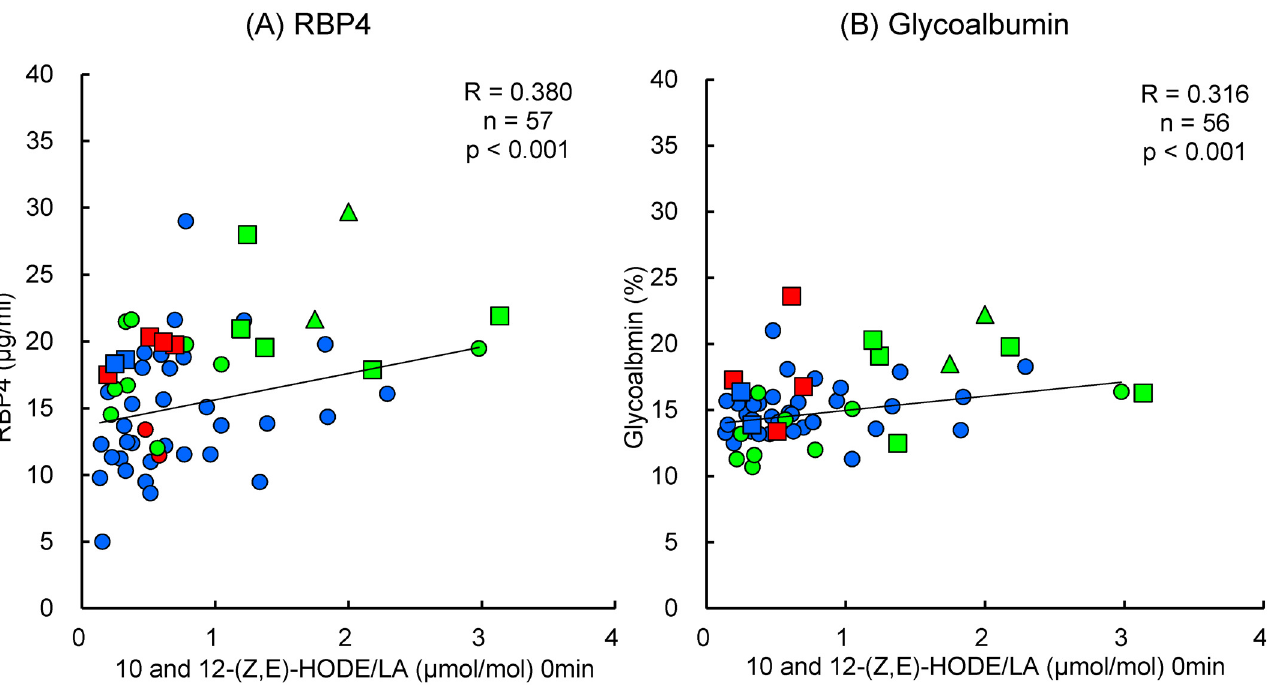
Fig 4. Correlation of 10- and 12- (Z , E) -HODE fasting plasma levels with (A) RBP4 and (B) glycoalbumin. Blue, normal insulin resistance; red, borderline insulin resistance; green, insulin resistance determined by homeostasis model assessment of insulin resistance and Matsuda Index 3. Circle, Group N (normal); square, Group HN+IGT ( “ high-normal ” and impaired glucose tolerance); triangle, Group D (diabetic). 10- and 12-( Z , E )-HODE, 10- and 12-( Z , E )- hydroxyoctadecadienoic acid; RBP4, retinol binding protein 4.